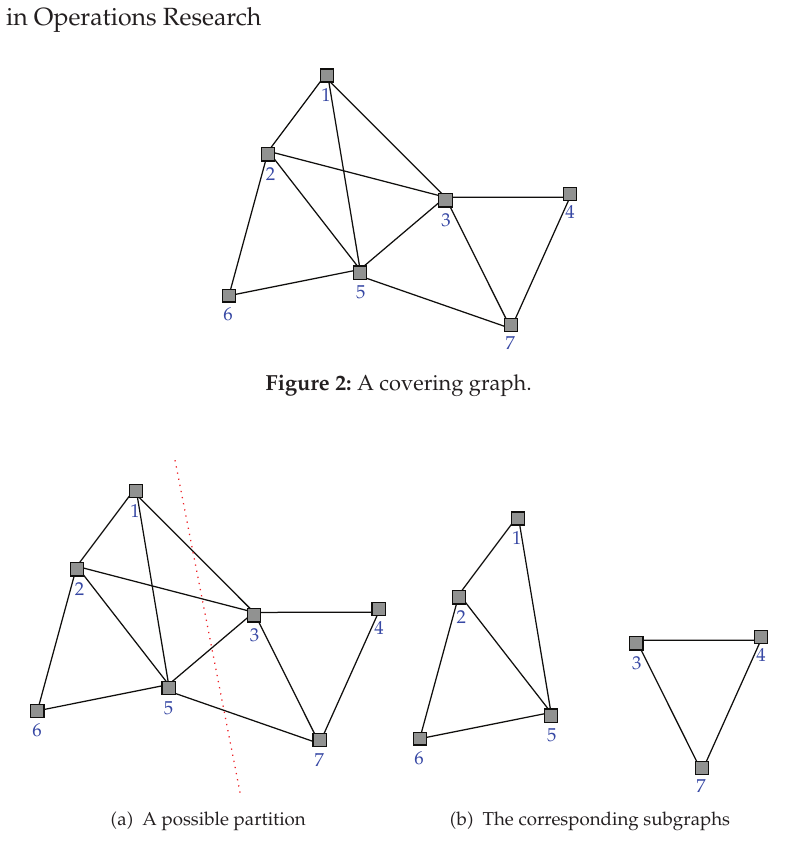
Figure 3: Partitioning a covering